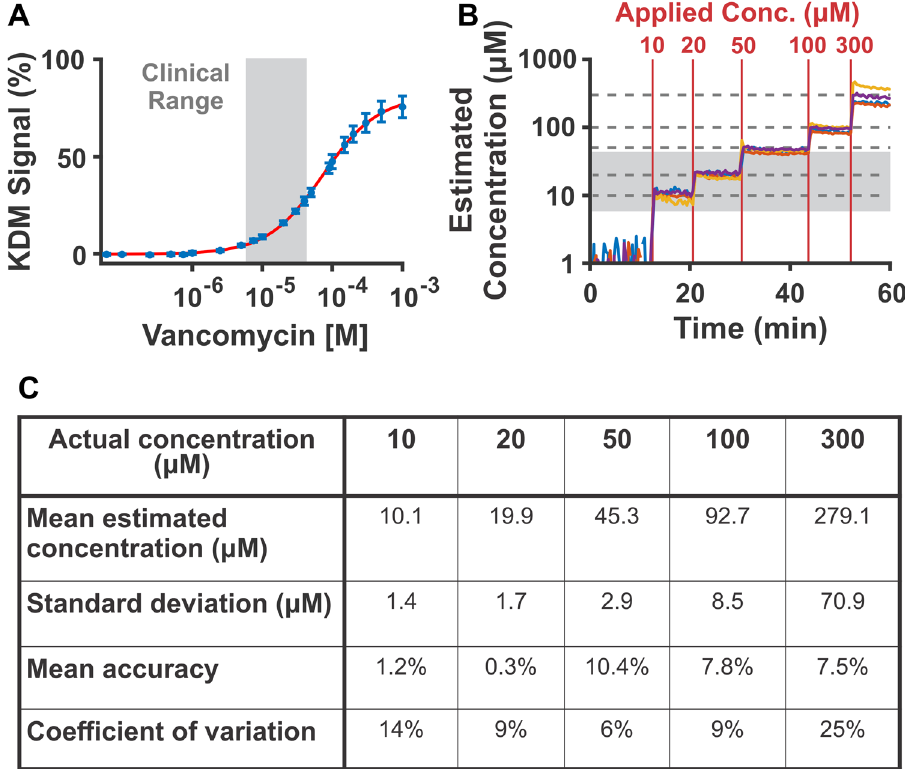
Figure 2. Vancomycin-detecting EAB sensors calibrated using a calibration curve collected in matched media and temperature easily achieve clinically useful measurement accuracy. ( A ) Here we created a calibration curve by fitting the average response of four sensors to a Hill-Langmuir isotherm using data collected at 37 °C in freshly-collected rat blood. We derive KDM values by subtracting the normalized peak heights collected at 300 Hz from those collected at 25 Hz, and dividing by their average 16 . We indicate the clinical range of vancomycin in grey. Specifically, the clinical window of vancomycin ranges from 6 to 42 µM, which reflects the minimum target concentrations to achieve clinical effect, to the mean maximum peak concentrations concentrations 26,27 . The error bars shown here and in the following figures reflect the standard deviation of replicate measurements performed using independent sensors (K 1/2 = 73 ± 4 µM, n = 4). The error reported for these and all other K 1/2 values reflect 95% confidence intervals. ( B ) We then apply this calibration curve to quantify measurements performed using the same four sensors in 37 °C fresh rat blood to which 10, 20, 50, 100, or 300 µM vancomycin has been added (dotted lines, red lines). We indicate the clinical range of vancomycin in grey. ( C ) From these measurements, we calculate mean estimated concentration, standard deviation, mean accuracy (defined as 100*(expected – observed)/observed), and coefficient of variation (100*population standard deviation/population mean). We observe better than 10% accuracy for all